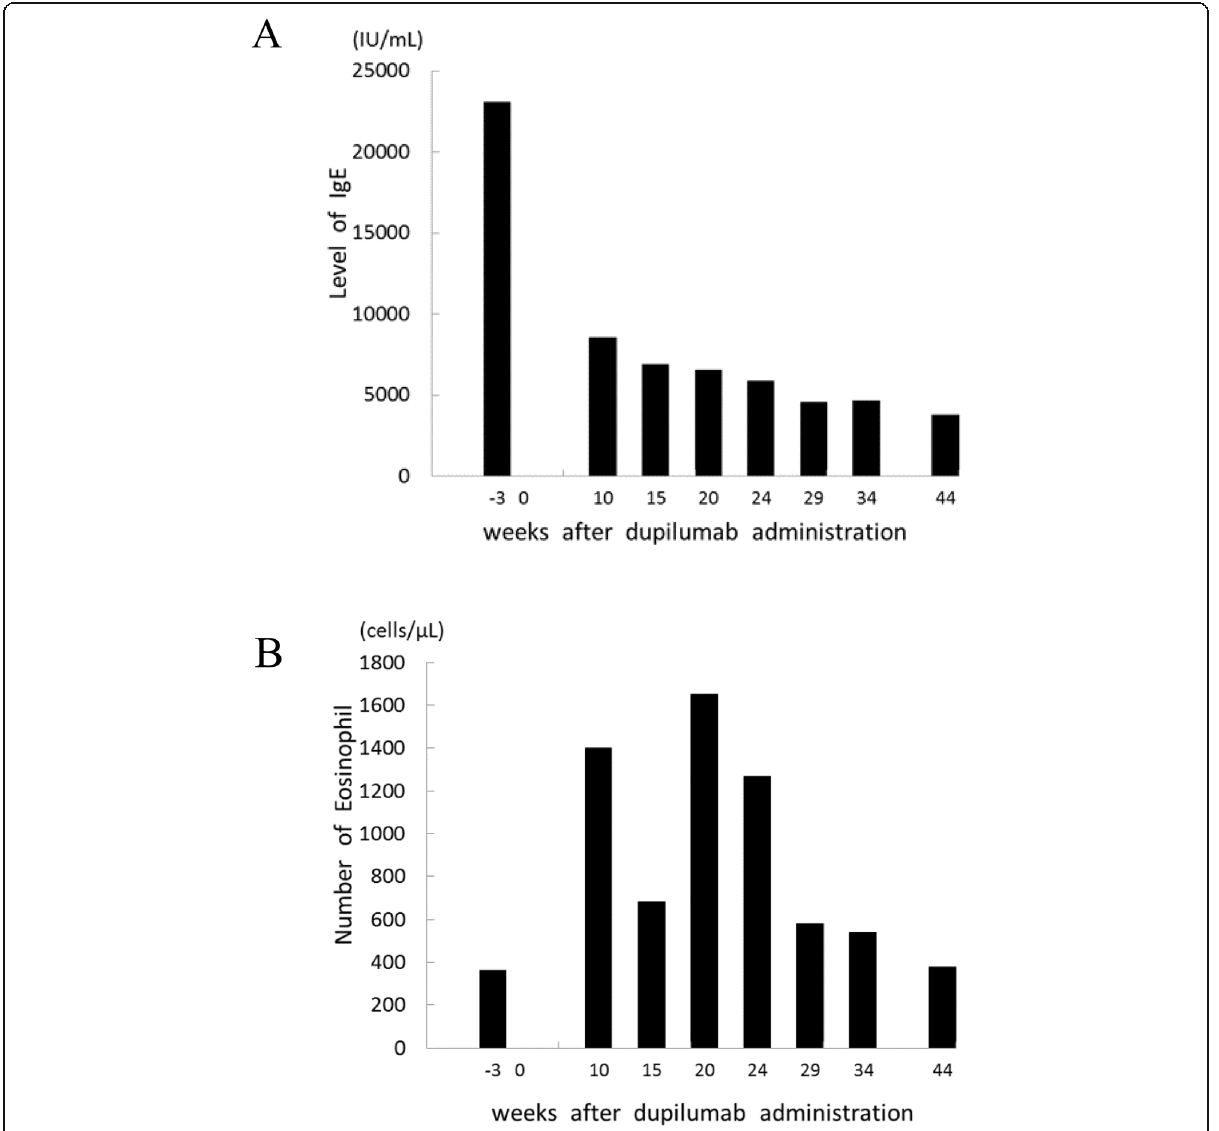
Fig. 2 Decreased levels of IgE and paradoxical transient eosinophilia in peripheral blood after dupilumab therapy. IgE level decreased markedly from 23,100 IU/mL at 3 weeks before to 8520 IU/mL at 10 weeks after dupilumab administration ( a ). The number of eosinophils paradoxically increased from 365 cells/ μ L at 3 weeks before to 1400 cells/ μ L at 10 weeks after dupilumab administration ( b